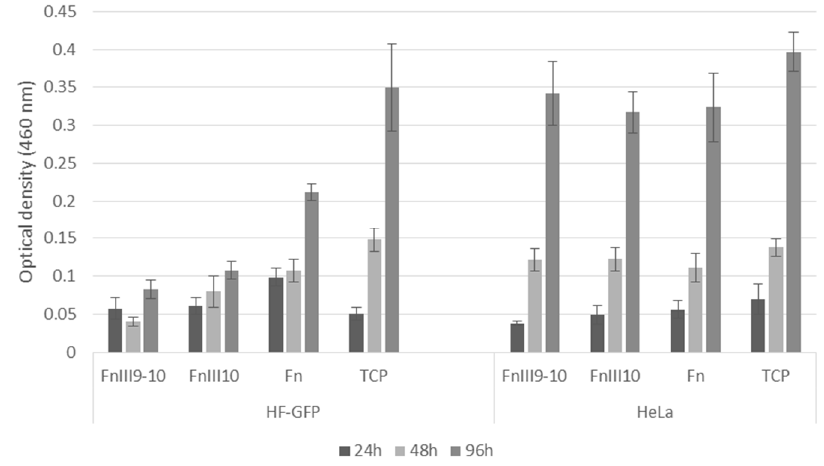
Figure 6. CCK-8 proliferation assay of GFP-transfected human fibroblast (HF-GFP) and HeLa cells cultured on FnIII9-10, FnIII10 and Fn -modified biochip surfaces and tissue culture plate (TCP). The error bars represent the standard error between all counts for each sample type.